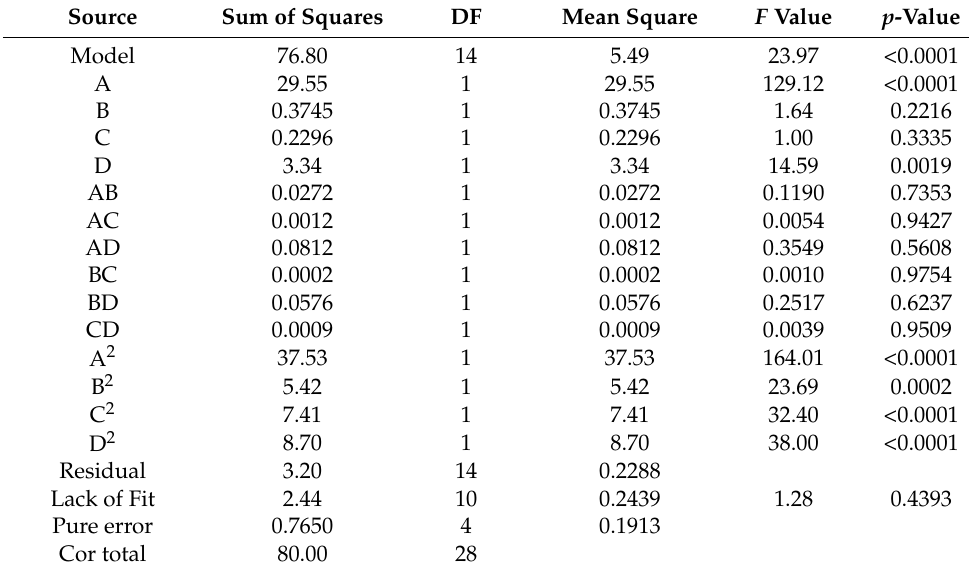
Table 3. ANOVA of the regression model for NADES-MAE